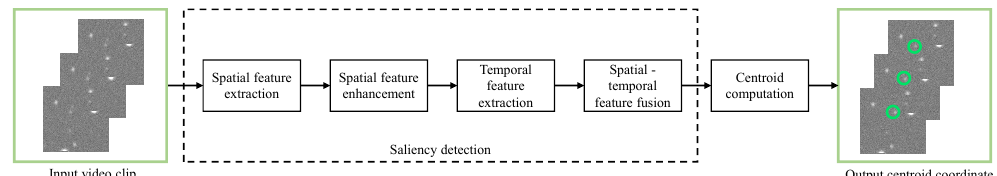
Figure 1. Flow chart of the proposed space debris detection